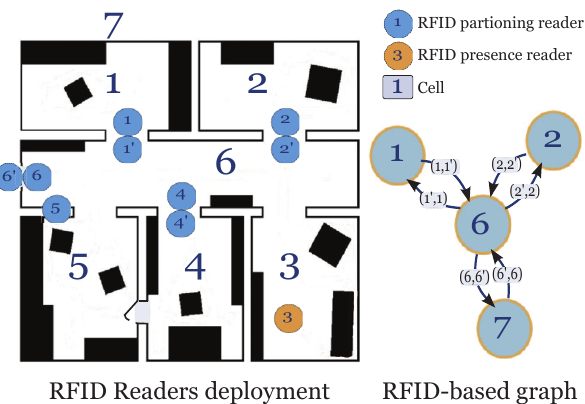
Figure 10: Example of a sensor-based